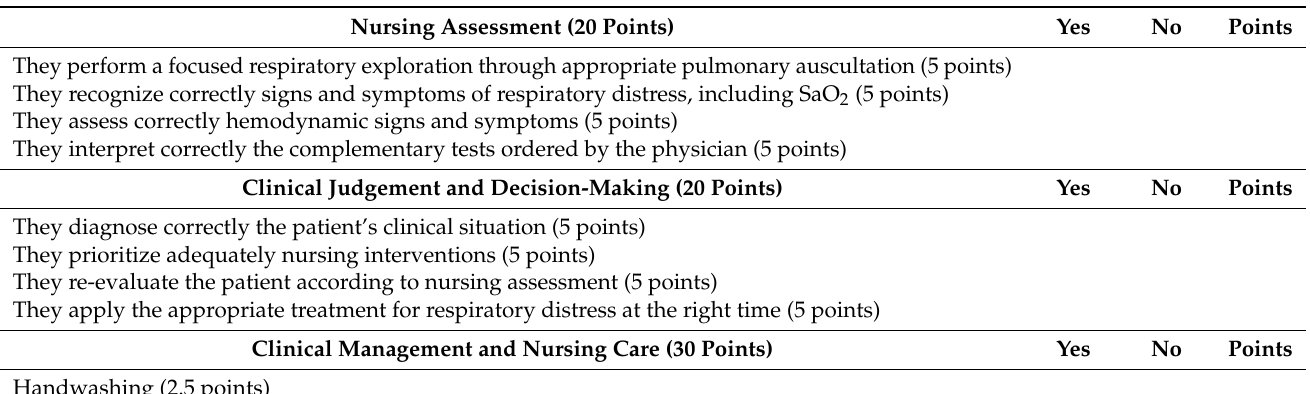
Table 2. Checklist of the required nursing competencies in the exacerbation of Chronic Obstructive Pulmonary Disease (COPD) OSCE